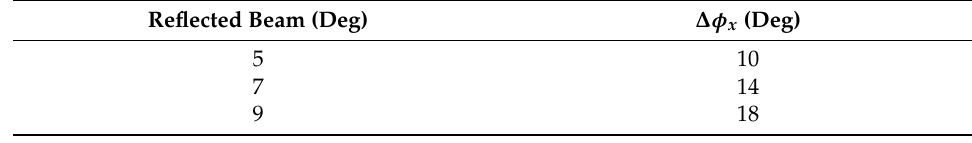
Table 3. Parameter values in Equation (1) for beam steering (periodicity ∆ x = 3.4 mm).